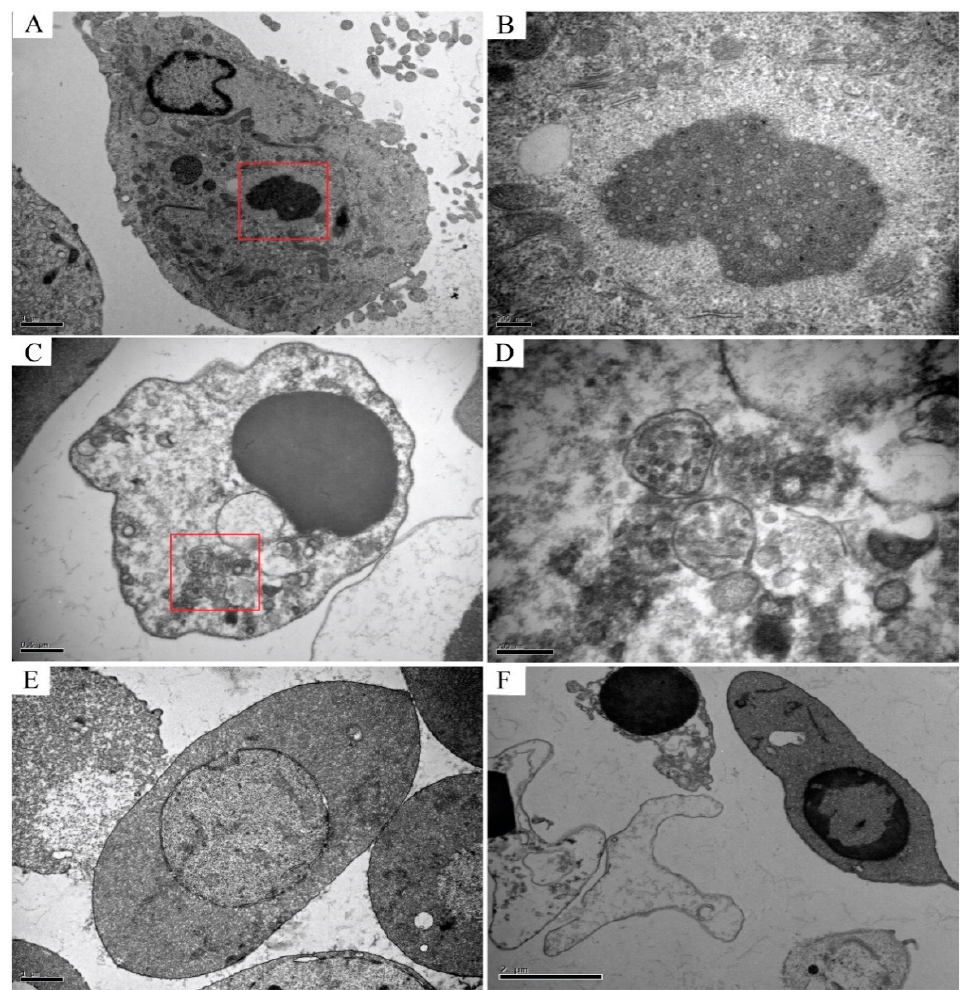
Figure 5. Transmission electron microscope observation of leukocytes, erythrocytes, and thrombo- cytes after infection with GCRV-II virus. ( A , B ) are the virus inclusion bodies (VIBs) in CIK cells infected with the virus. The structure is dense and contains a large number of virions in the process of being formed, without apparent membrane structure outside; ( C , D ) are virions in infected leukocytes that exist in the cytoplasm in the form of a relatively obvious envelope structure, which envelops a large number of virions, and the interior is not dense, showing a vacuole structure; ( E ) and ( F ) are respectively infected erythrocytes and thrombocytes, both cells have no noticeable pathological changes, and their constructions are complete.